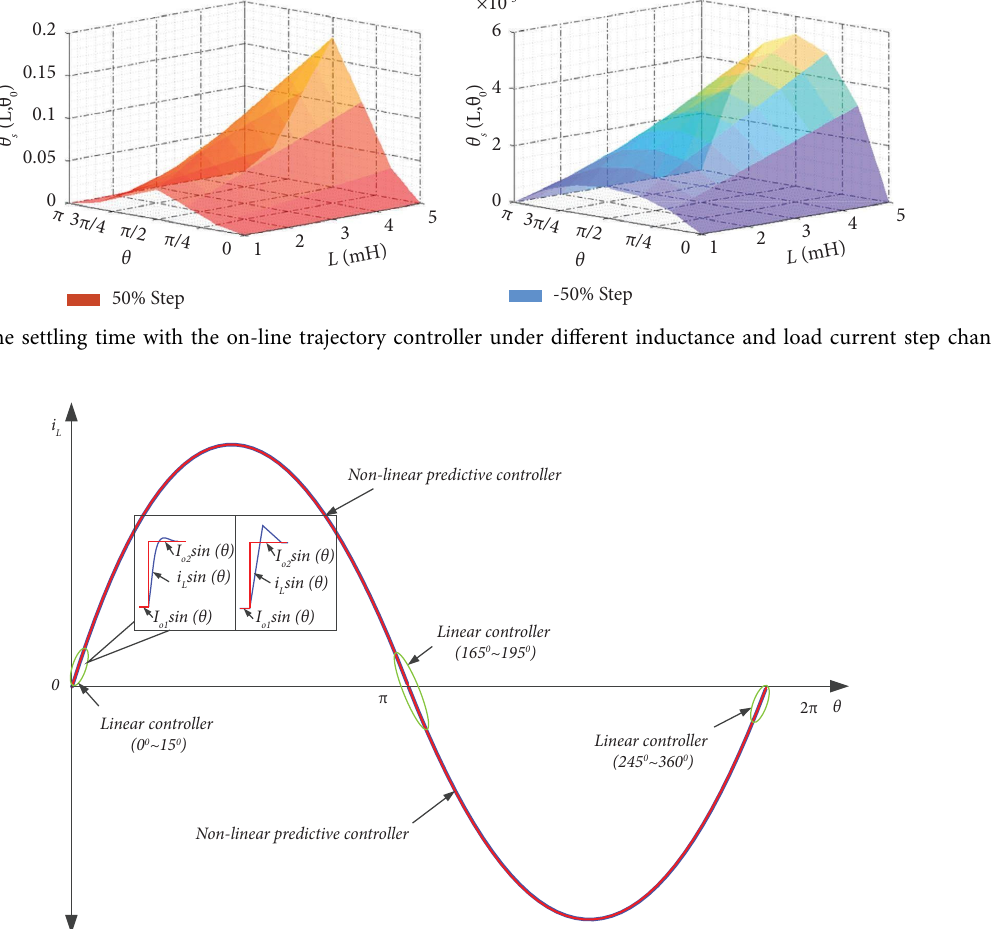
Figure 9: Te suitable load step-change condition for the single-phase VSI with the on-line trajectory control